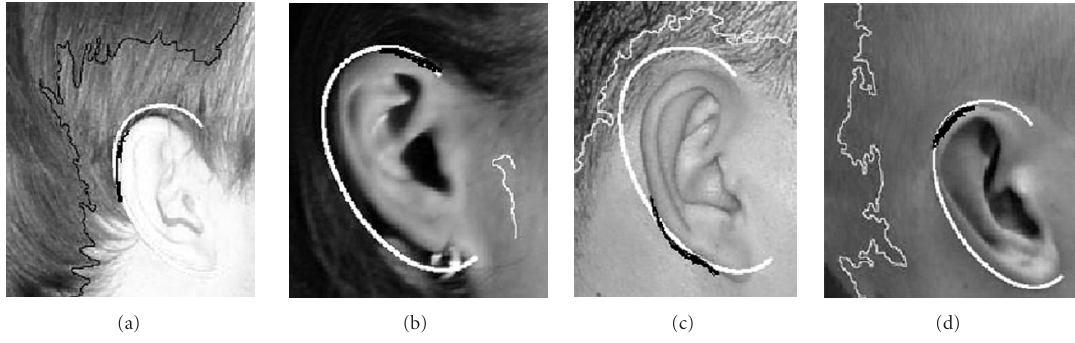
Figure 12: The results of ear initialization using edge segments when skin-color boundary is